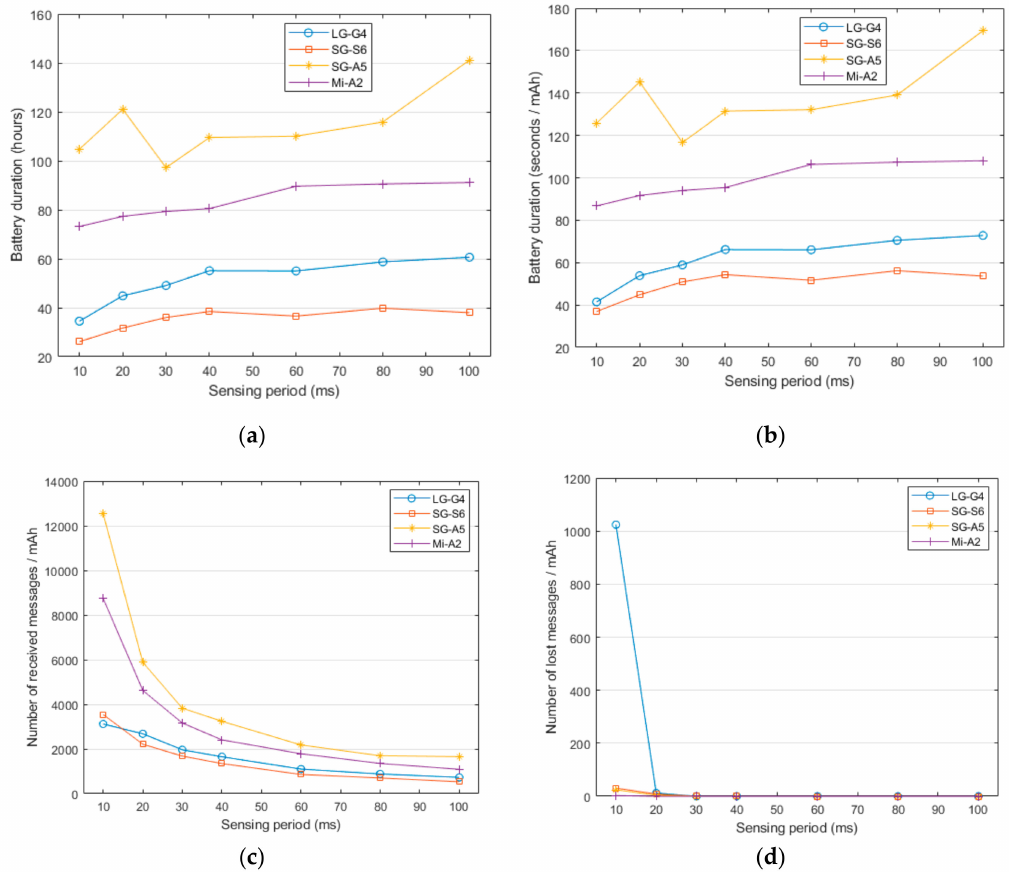
Figure 1. Performance metrics as a function of the sampling period. ( a ) Battery duration; ( b ) relative battery lifetime (lifespan per consumed mAh); ( c ) number of messages received per consumed mAh; ( d ) number of lost messages per consumed mAh.